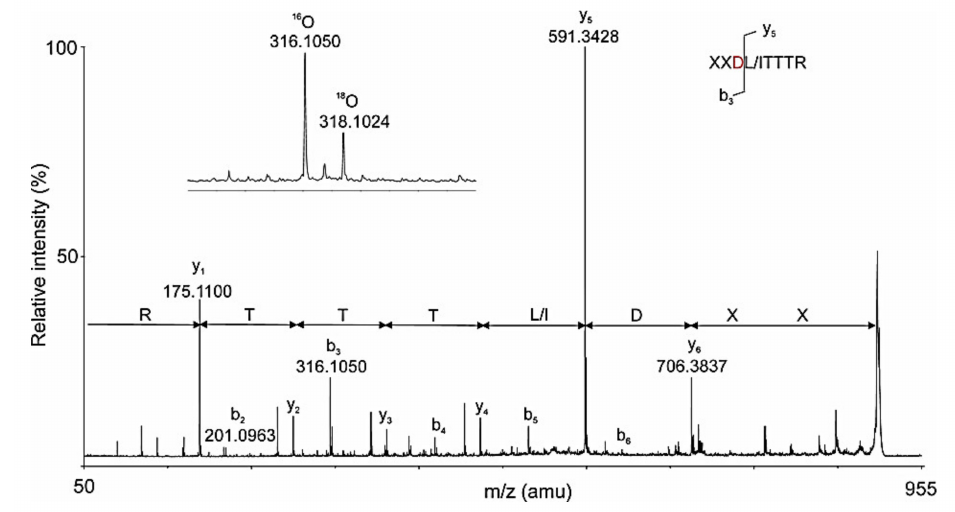
Figure 16. T О F spectrum of 18 O-labeled peptide, presented from an ion with m / z 966 [M-2H] 2 + ; collision energy 28 eV and TDF time 8 ms. B) The labeled ion b 3 with m / z 316.1050 is depicted on the figure. Table 2. AAS and carbohydrate structures of glycopeptides from RvH analyzed by ESI-MS, Q-Trap-LC / MS / MS and Q-Trap system. X is unknown IF [28,29,33]. Glycopeptides Glycans Mass / Charge ( m / z )